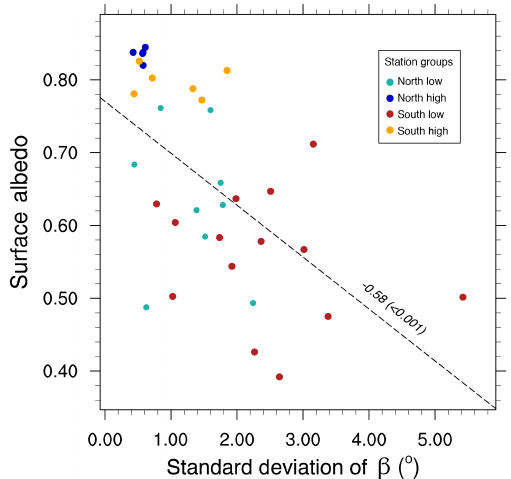
Figure 9. Correlation between surface albedo and the standard de- viation of tilt angles ( β ). Numbers on dashed lines are the correla- tion coefficients. Numbers in the parentheses are the corresponding significant levels based on a two-tailed t test. The KAN_B station, which is anchored into rock is not included.